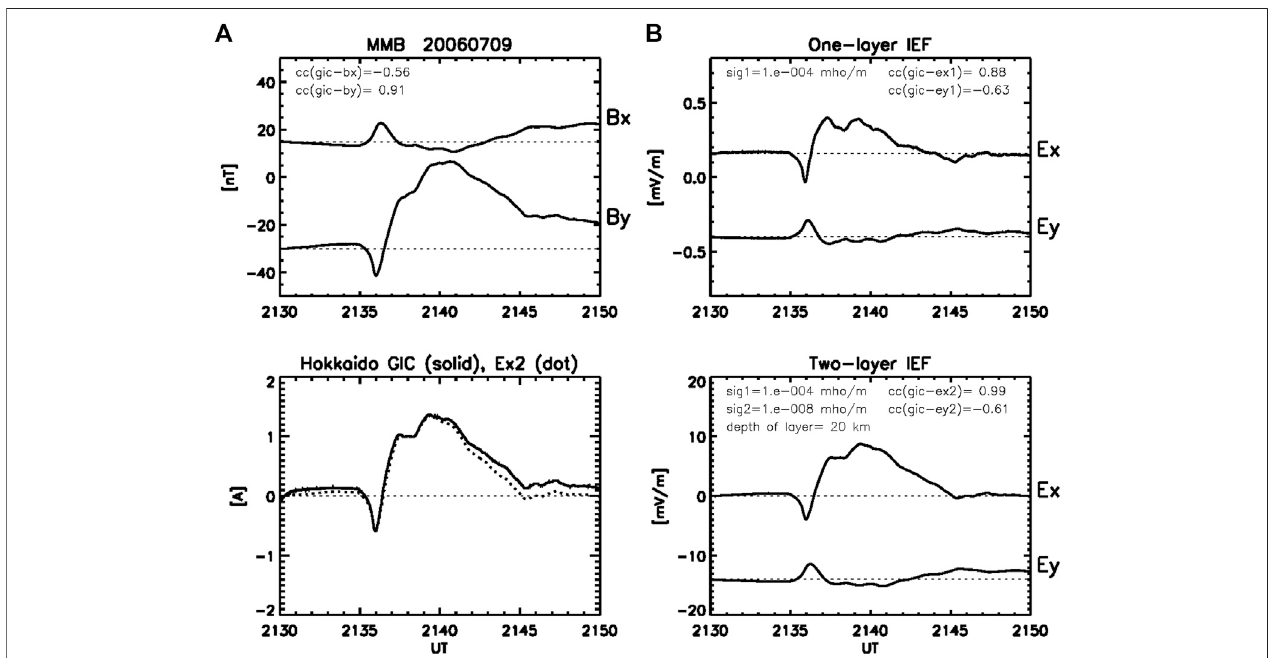
FIGURE 2 | (A) B x , B y and GIC observed at MMB, and (B) E x and E y calculated in the one- and two-layer models for the SC event with time scales of 1 – 10 min observed in the morning sector (2130 UT, 0630 MLT). The parameters and formats of the plots are the same as in Figure 1 .